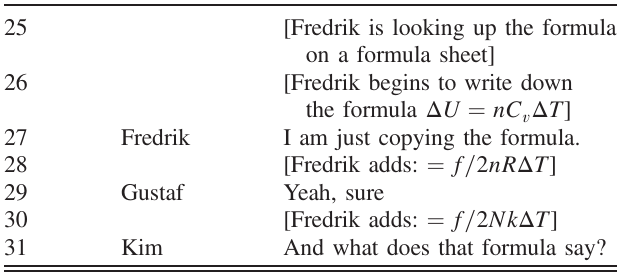
TABLE III. Transcript of a transformation of a formula. Continuation of Table V.